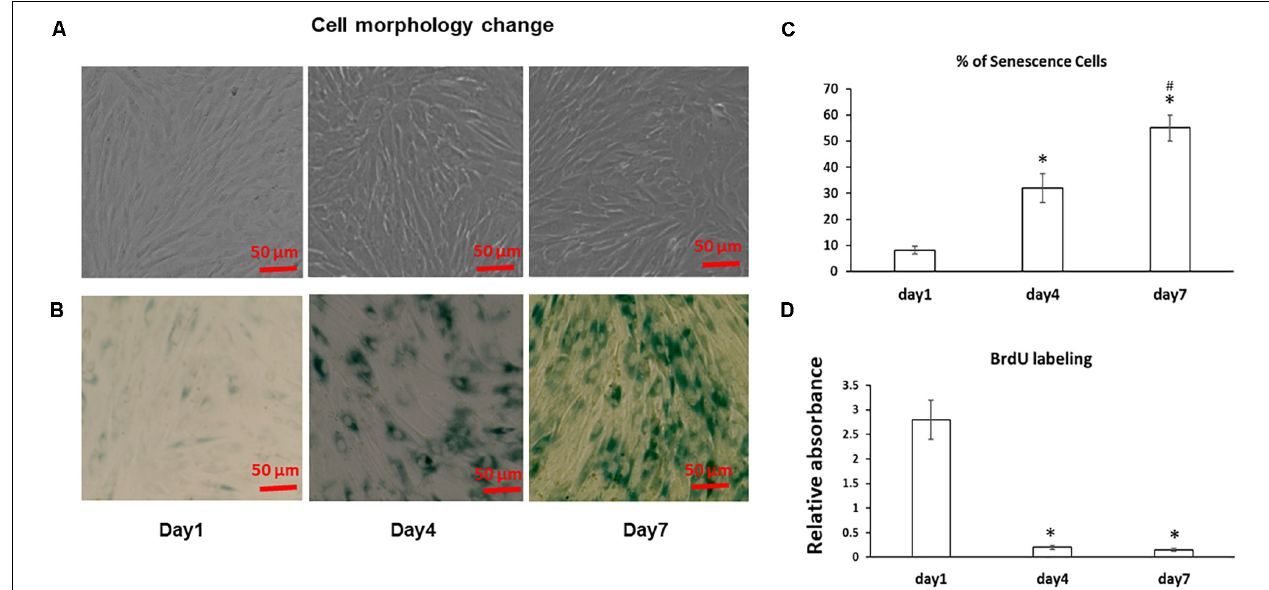
FIGURE 1 | Cell morphology change and aging in BMSC sheet cultures. (A) BMSCs were cultured in cell sheets at Days 1, 4, 7 and visualized by microscope. Scale bar, 100 µ m. (B) SA- β -gal staining was performed to determine the extent of senescence in 1, 4, and 7 Day cell sheet cultures. Scale bar represents 100 µ m. (C) SA- β -gal positive cells were quantitated by ImageJ. (D) Cell proliferation was determined by BrdU labeling in cell sheet cultures at Days 1, 4, and 7. All experiments were performed in triplicate. * P < 0.05 vs. Day 1 cells and # P < 0.05 vs. Day 4